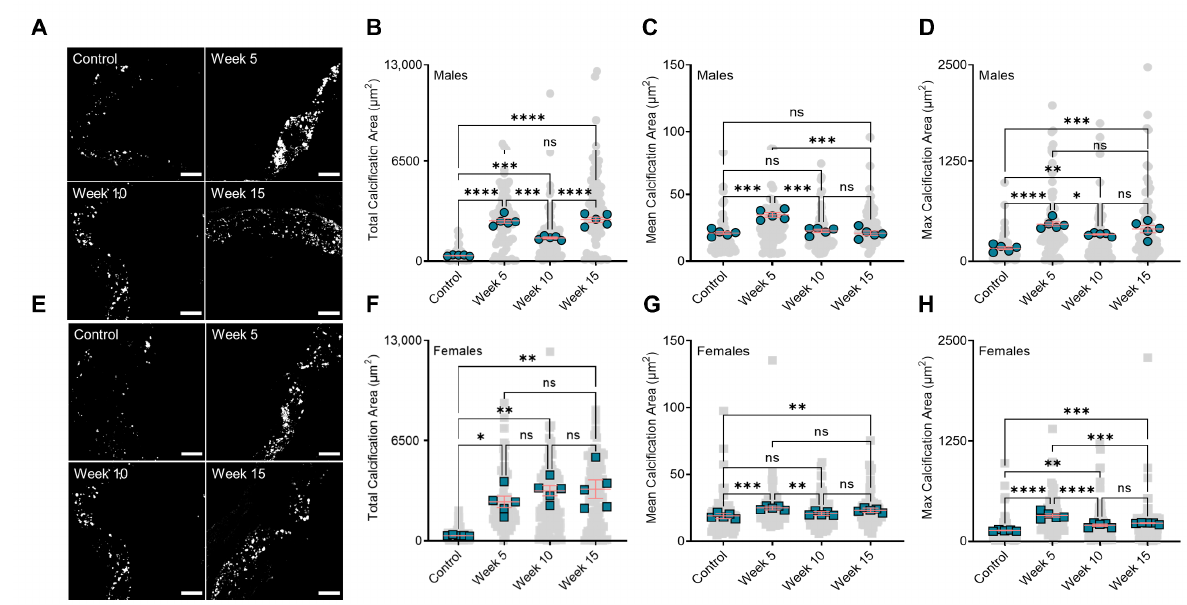
Figure 2. BiP treatment alters the micromorphology of the minerals in the atherosclerotic plaque. ( A ) Visualization of the minerals in the atherosclerotic plaques of male mice (20×, scale bar 100 μ m); ( B ) total plaque calcification in male mice; ( C ) mean calcification area (mean of mineral size) in male animals; ( D ) maximum calcification area in male mice; ( E ) visualization of the minerals in the atherosclerotic plaques of female mice (20×, scale bar 100 μ m); ( F ) total plaque calcification in female mice; ( G ) mean calcification area (mean of mineral size) in female animals; ( H ) maximum calcification area in female mice. Note that gray points ( ● or ■ ) in the background represent technical replications, i.e., all calcifications measured across all mice, and green points ( ● or ■ ) represent the biological replications, i.e., the average value for each mouse. * p < 0.05, ** p ≤ 0.01, *** p ≤ 0.001, and **** p ≤ 0.0001, two-way ANOVA with Tukey’s post-hoc test. “ns” stands for not significant.